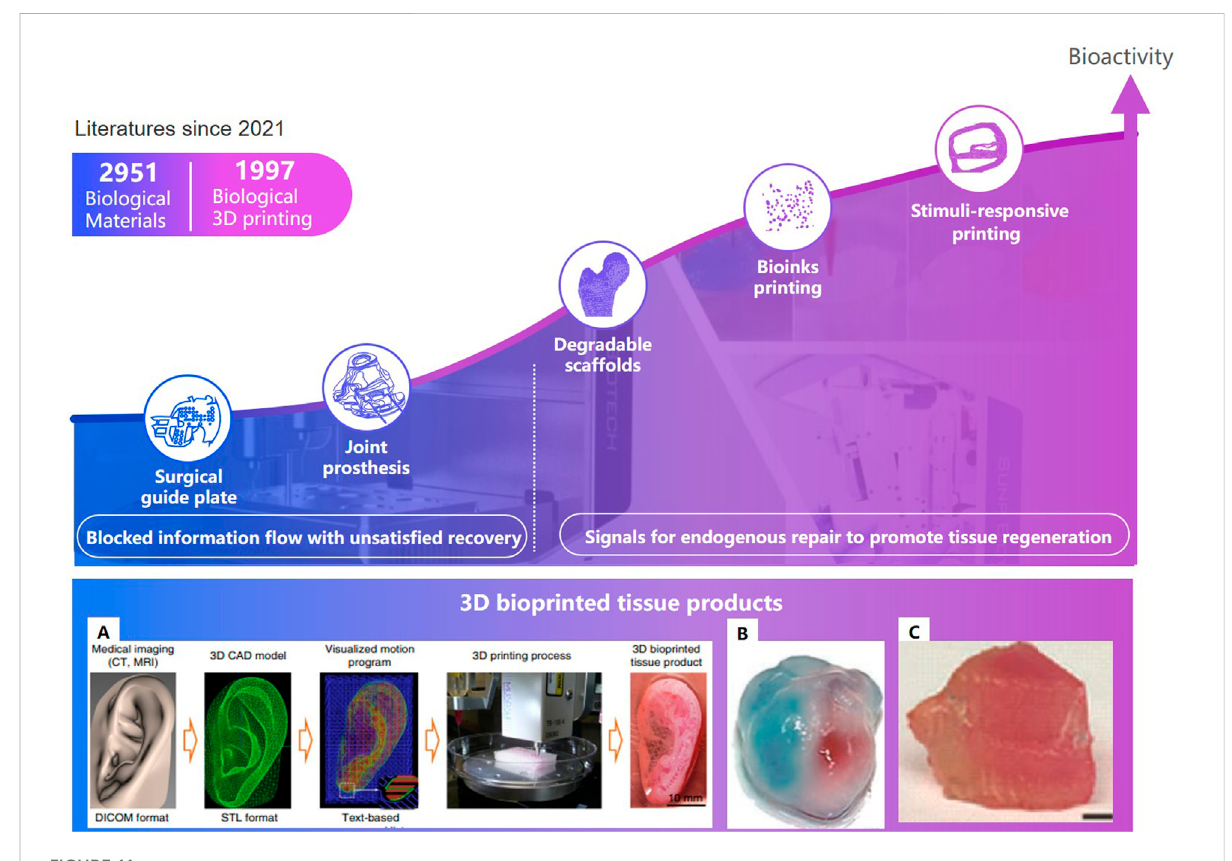
FIGURE 11 Developmentoftissue engineeringand 3Dbioprinted tissueproduct. (A) .TheITOP system(Grolletal.,2018). (B) .Ventricles (Zhang etal.,2016). (C) . Thyroid cartilage (Van Belleghem et al.,